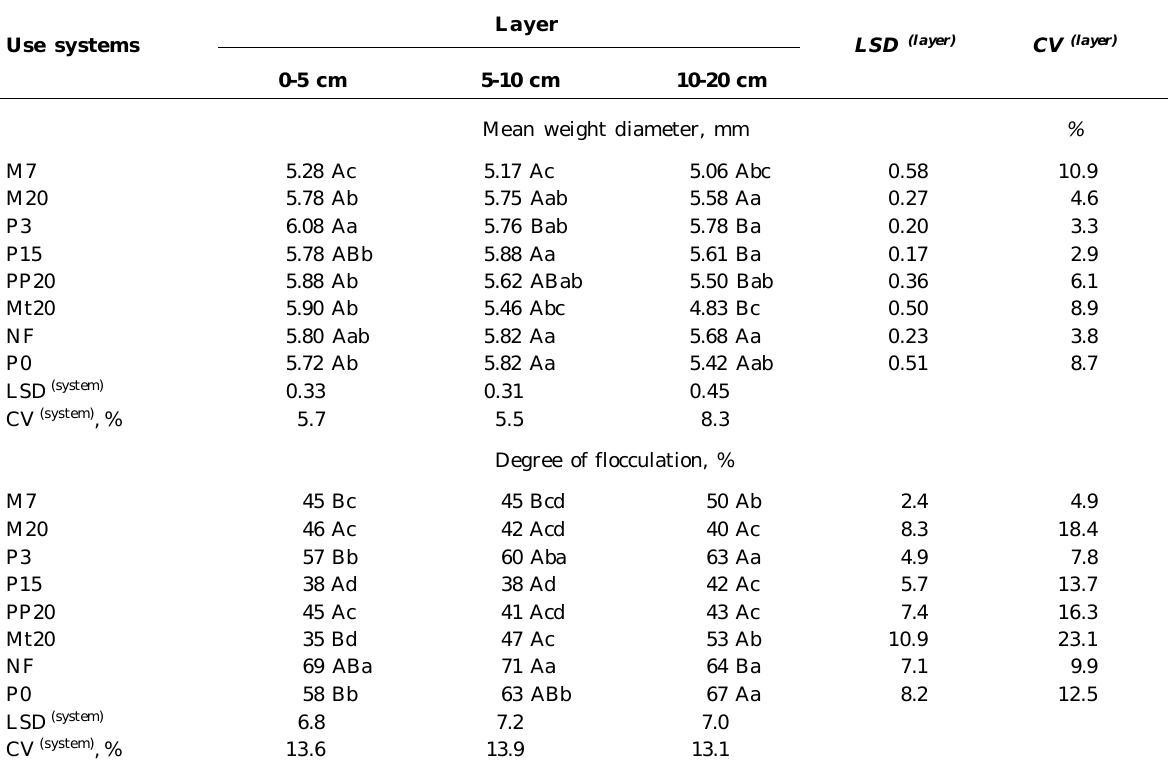
Areas studied: M7: maize after 7 years of organic fertilizer applications; M20: maize after 20 years of application; P3: annual pasture after 3 years of application; P15: annual pasture after 15 years of application; PP20: perennial pasture after 20 years of application; Mt20: yerba mate with 20 years of application; NF: native forest; P0: native pasture. Capital letters, in the rows, compare layers and small letters, in the columns, compare use systems, by the t test (p <0.05). LSD: least significant difference; CV: coefficient of